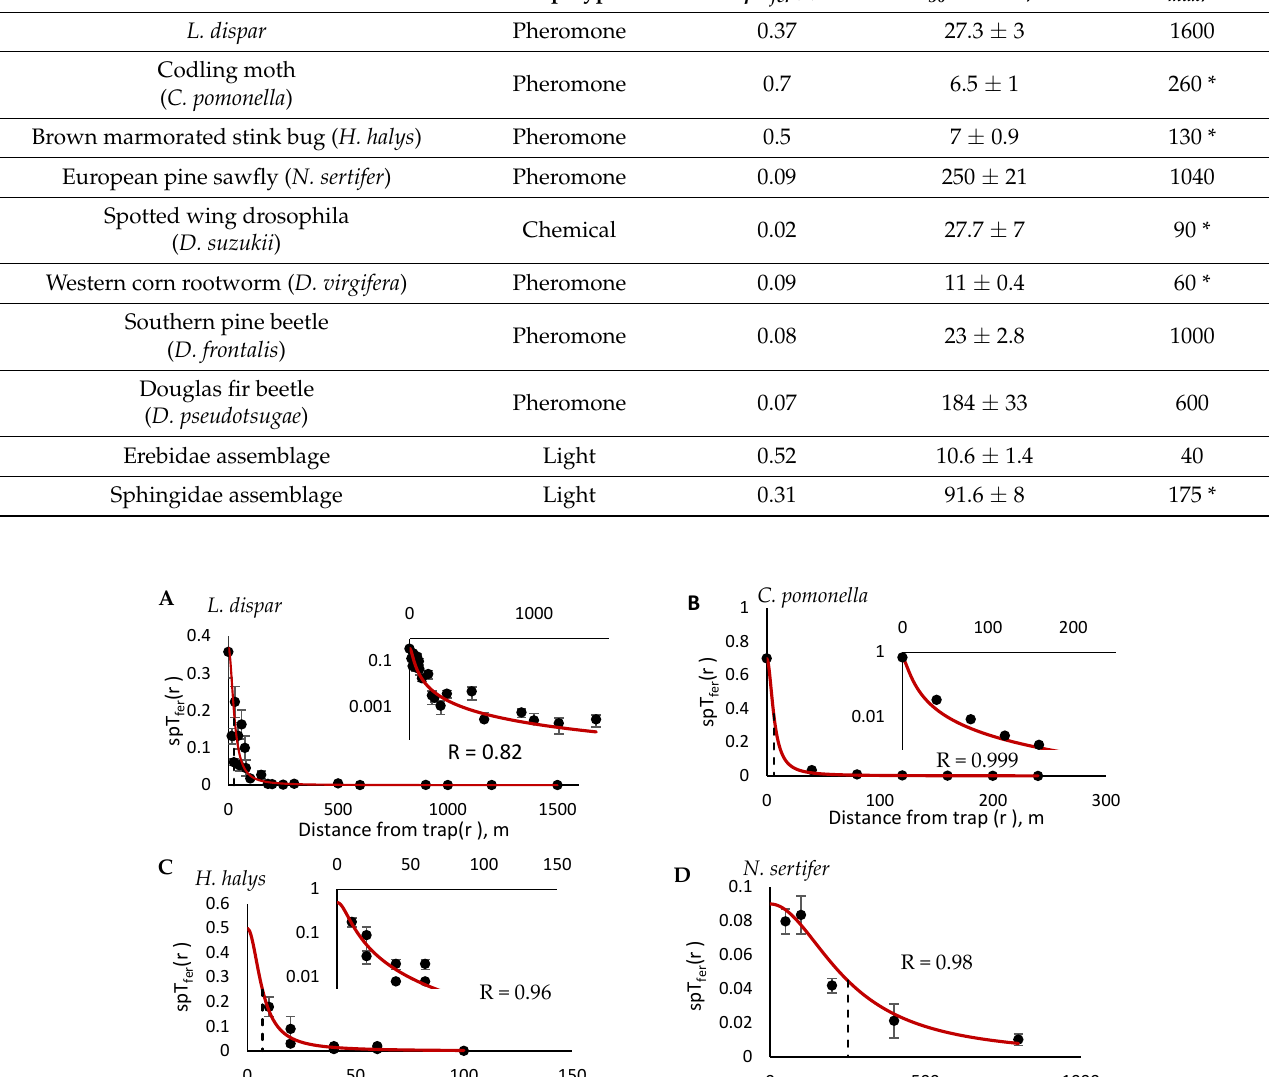
Table 1. Estimates of the probability to catch an insect released in the immediate proximity to the trap ( spT fer (0)) and D 50 for various insects in the orders Lepidoptera, Coleoptera, Hymenoptera, Diptera, and Hemiptera. Experimental R max is listed for L. dispar , N. sertifer , D. frontalis , D. pseudotsugae , and Erebidae assemblage; for C. pomonella , H. halys , D. suzukii , D. virgifera , and Sphingidae assemblage, R max was estimated using the method described by Miller et al. [45] and is marked with an *.